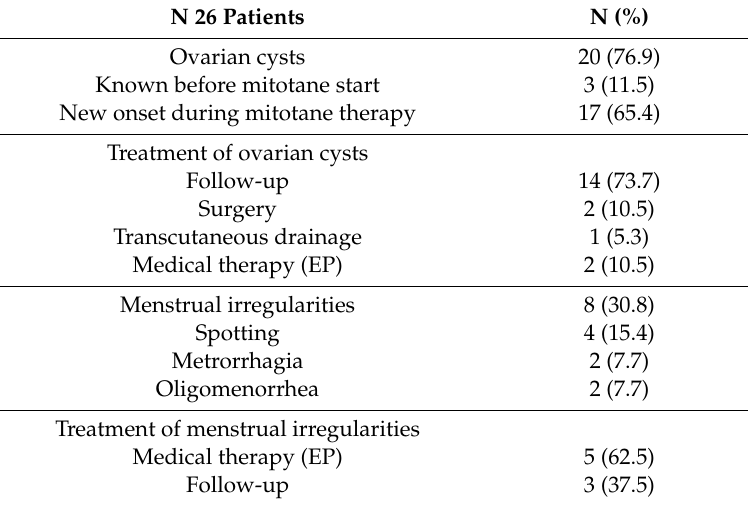
Table 3. Disturbance of gonadal function in fertile women.